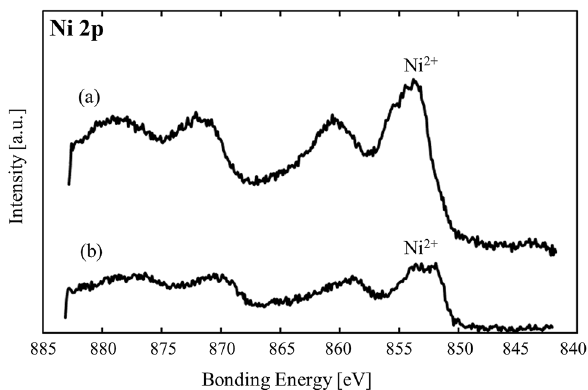
Figure 6. Ni 2p region of the XPS spectra for the ( a ) Ni/MEPCM and ( b ) Ni/α-Al 2 O 3 .